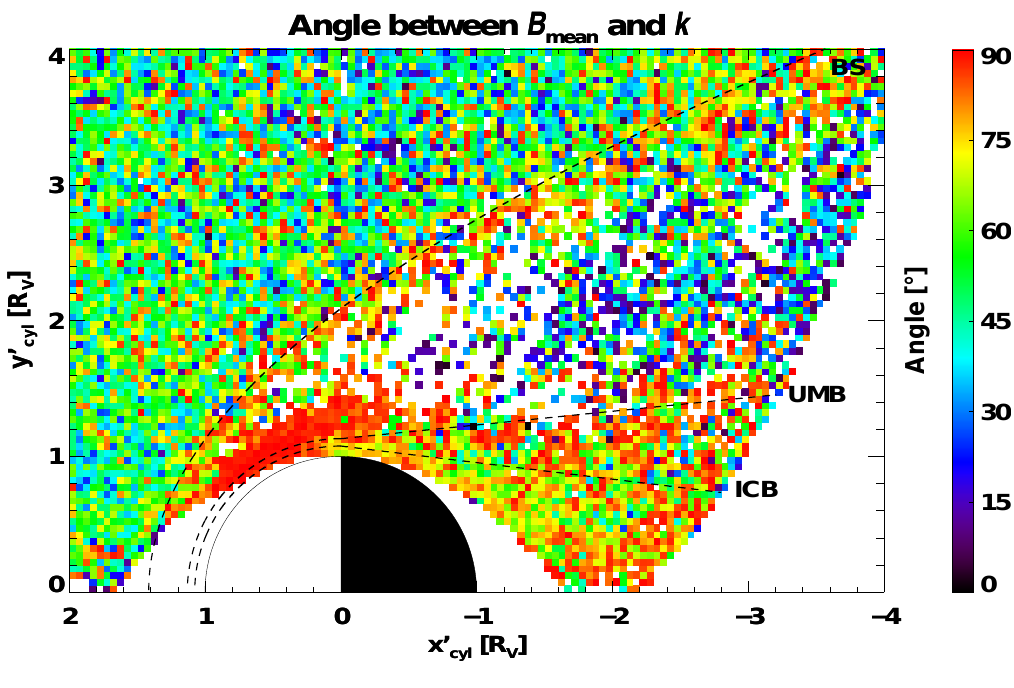
Fig. 7. Spatial distribution of the angles of the wave vector direction with respect to the mean magnetic field. Data gaps in the figure are due to the selection criterion of a ratio of the intermediate to the minimum eigenvalue greater than 5. The low-altitude dayside magnetosheath is characterised by the occurrence of large angles between the wave vector direction and the mean magnetic field. The tail and mantle region is dominated by angles greater than 45 ◦ , whereas in the nightside magnetosheath also smaller angles occur. In the upstream solar wind a wider distribution of angles is